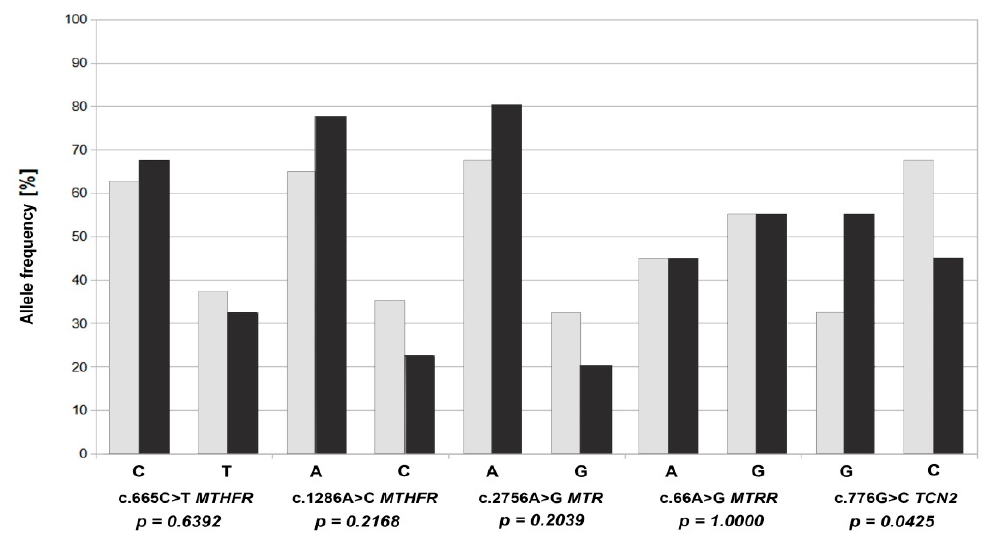
Figure 2. Frequency of occurrence of reference and alternative alleles of selected variants c.665C>T MTHFR , c.1286A>C MTHFR , c.2756A>G MTR , c.66A>G MTRR and c.776G>C TCN2 in the control group (dark bar) and the study group (light bar). Table 1. Distribution of reference and alternative alleles in the control and study groups.